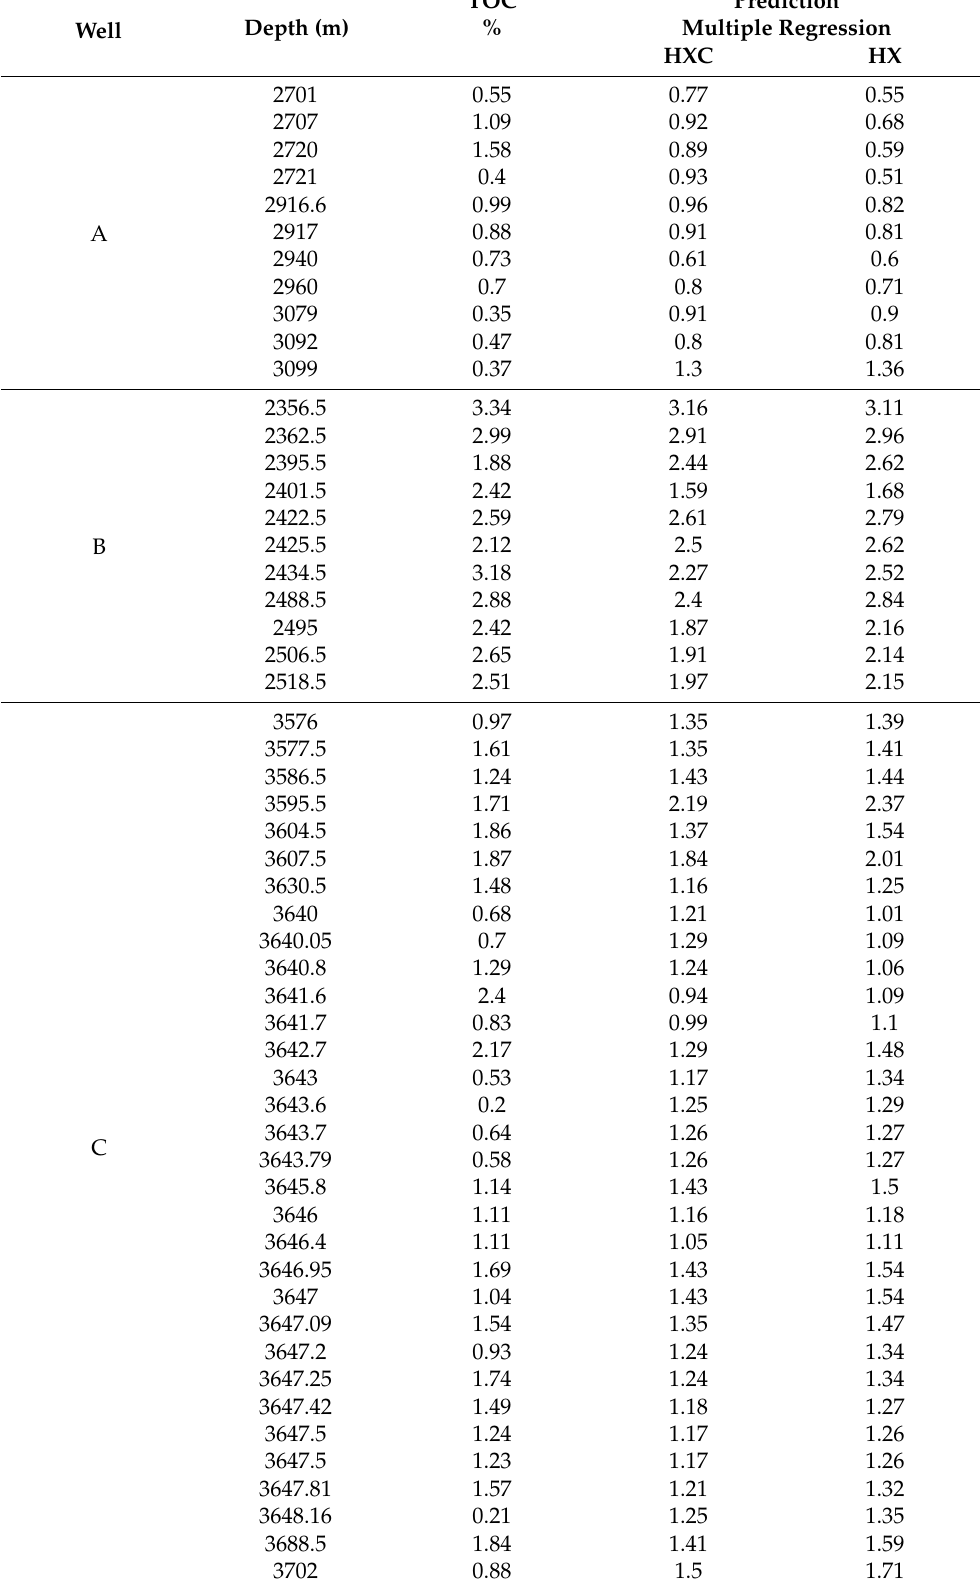
Table 3. Results of TOC prediction from multiple